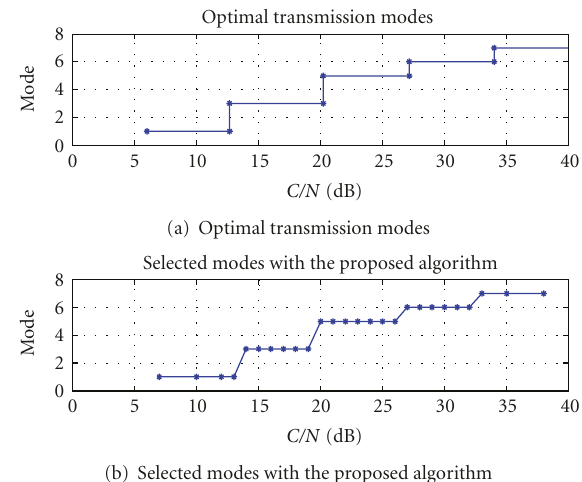
Figure 19: Mode selection comparison, foreman , GOP number 11, initial mode = 3, Set (b).